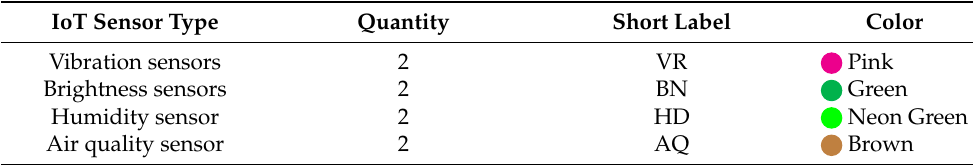
Table 3. Environment sensors of smart factory with short label and